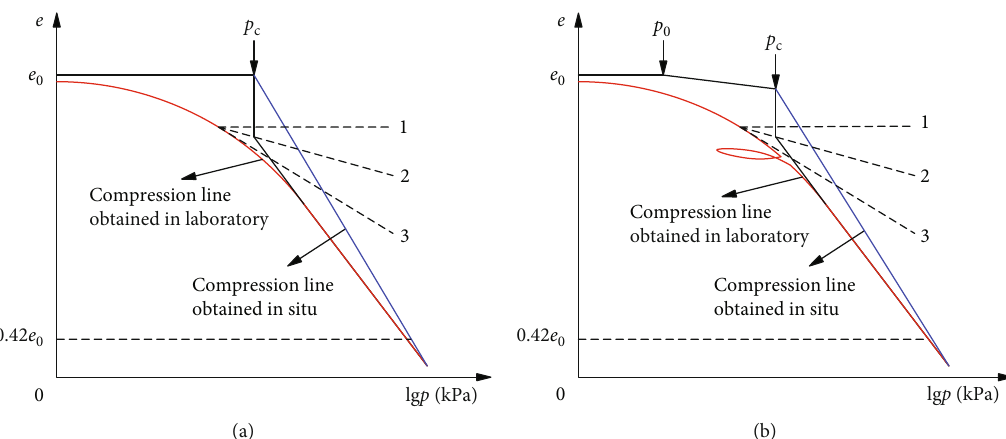
Figure 1: Schematic of compression lines obtained in the laboratory and in situ for (a) normally consolidated soil and (b) overconsolidated soil.